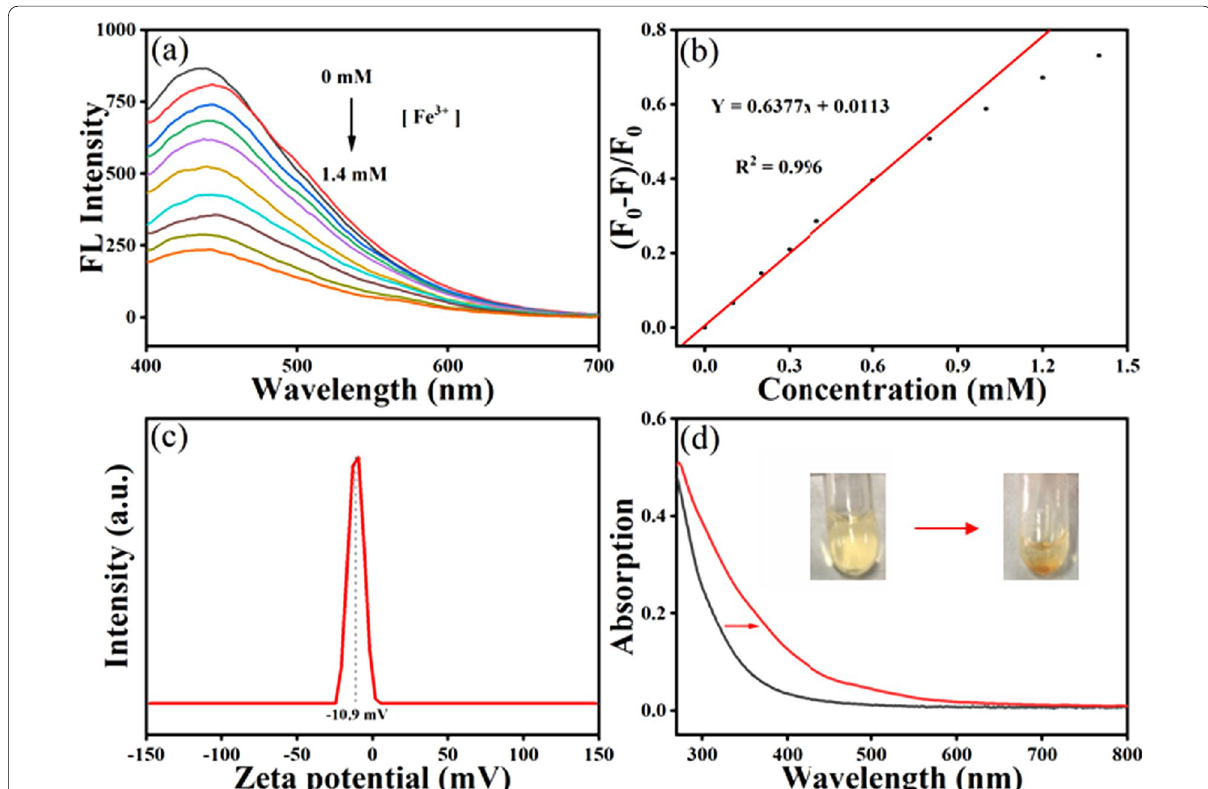
Fig. 4 a Fluorescence emission spectra of MQDs with the addition of ferric ion; b calibration line between the concentration of Fe 3 + and the fluorescence ratio; c the zeta potential of the prepared MQDs; and d UV–Vis absorption spectra of MQDs with and without the addition of Fe 3 + ions